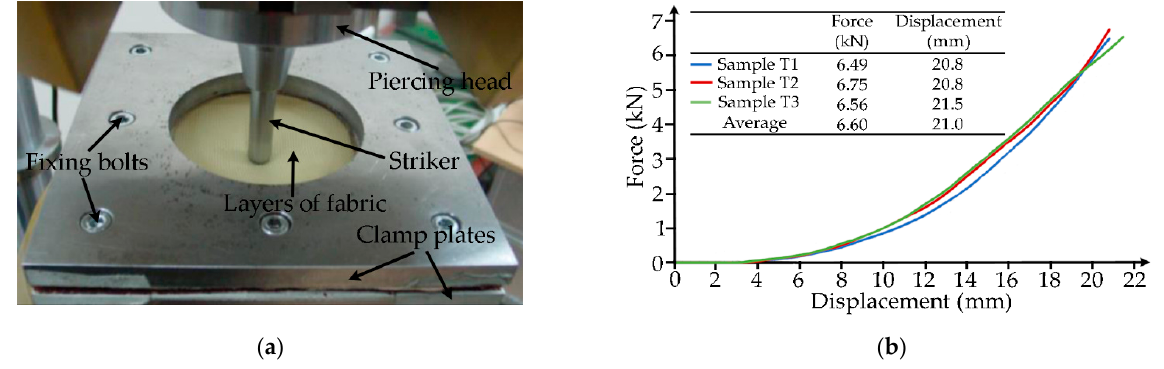
Figure 7. Experimental test of quasi-static penetration of Twaron CT 750 aramid fabric: ( a ) test stand and ( b ) example of results.